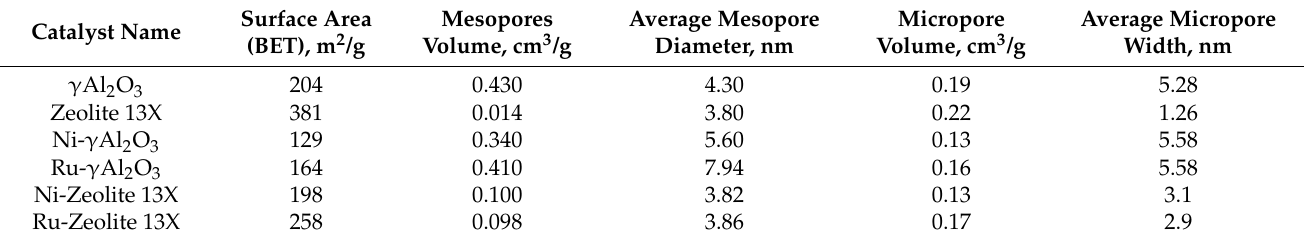
Table 1. Properties of the different catalytic